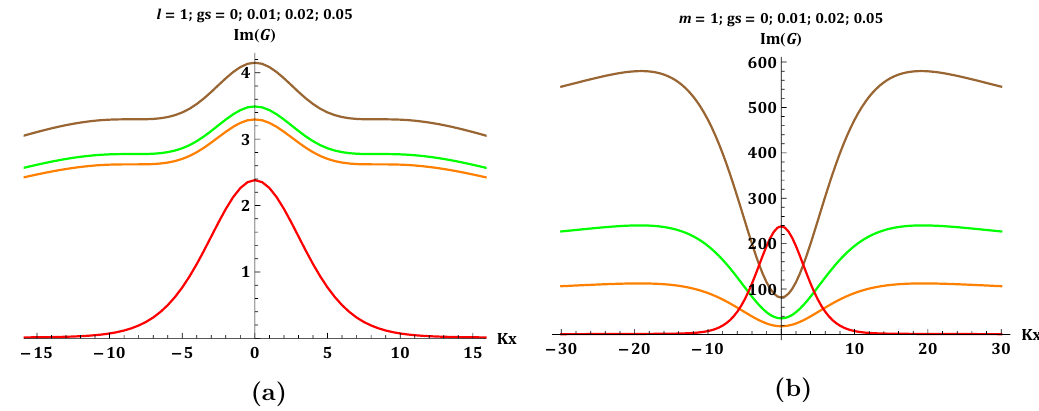
Figure 8. Plot of spectral density A vs. w with g s = 0 (red), 0.01 (orange), 0.02 (green), .05 (brown) (a) l = 1 , m = 0 , (b) l = 0 , m = 1